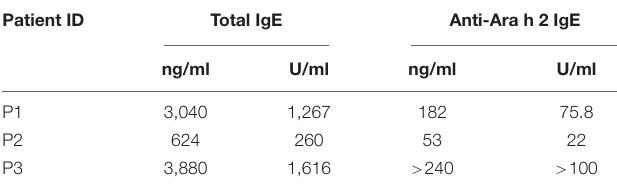
TABLE 2 | Characteristics of patient